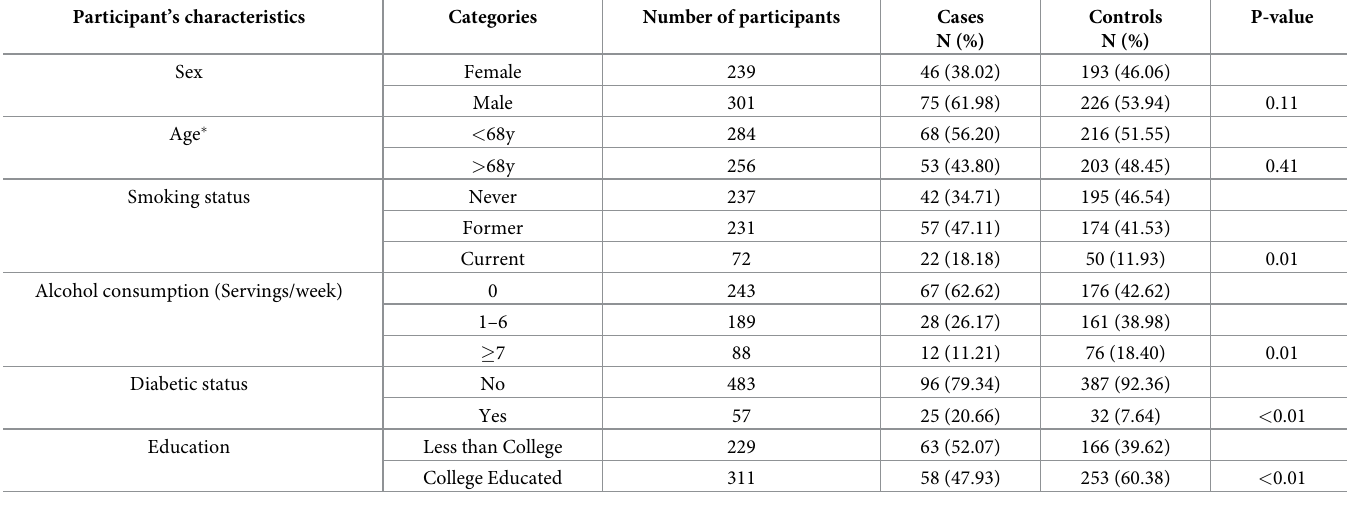
Table 1. Distribution of study participant characteristics among pancreatic cancer cases and controls.